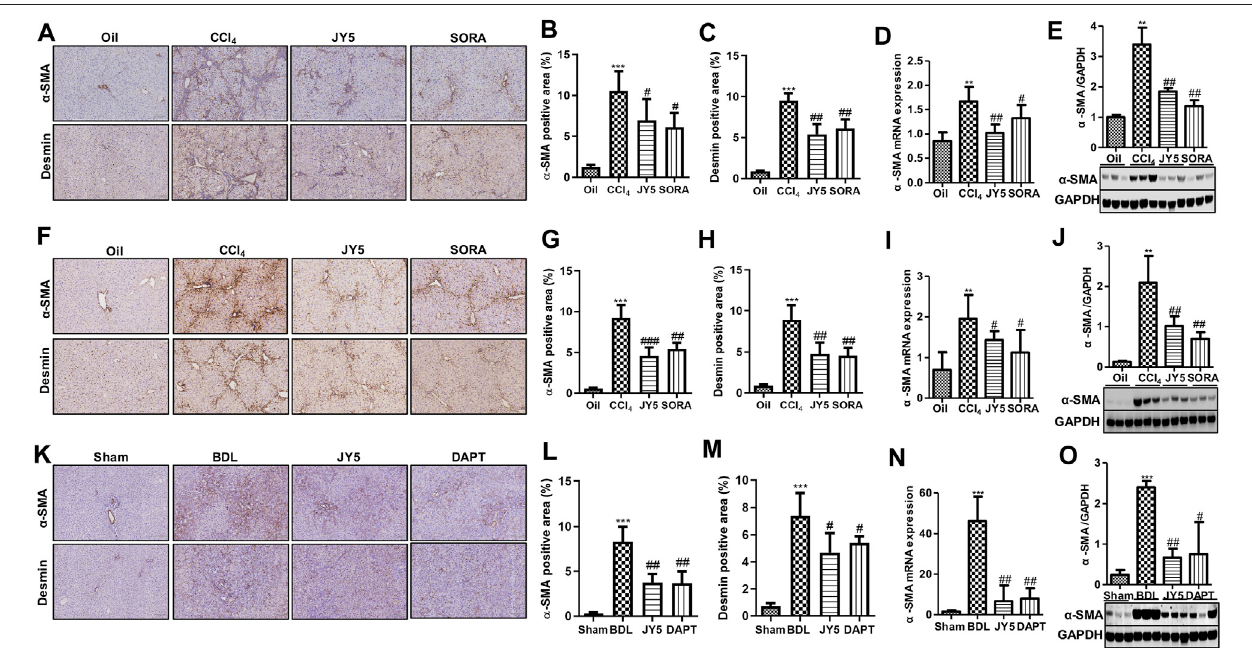
FIGURE 5 | JY5 inhibits the activation of HSCs in vivo . (A) In the CCl 4 -induced rat liver fi brosis experiment, representative images of IHC (100 × ) staining for a -SMA and desmin. Quantitative analysis of immunohistochemical staining for a -SMA (B) and desmin. (C) The protein and mRNA levels of a -SMA were, respectively, analyzed by qPCR (D) and Western blotting (E) . (F) In the CCl 4 -induced liver fi brosis mice experiment, representative images of IHC (100 × ) staining for a -SMA and desmin in liver tissue from mice treated with the various treatments. Quantitative analysis of immunohistochemical staining for a -SMA (G) and desmin. (H) The protein and mRNA levels of a -SMA in mice liver tissue were, respectively, analyzed by qPCR (I) and Western blotting (J) . (K) In the BDL-induced rat liver fi brosis experiment, representative images of IHC (100 × ) staining for a -SMA and desmin in liver tissue. Quantitative analysis of immunohistochemical staining for a -SMA (L) and desmin (M) . The protein and mRNA expression of a -SMA was, respectively, analyzed by qPCR (N) and Western blotting (O) . ** p < 0.01, *** p < 0.001 vs the control group or sham group, # p < 0.05, ## p < 0.01 vs the CCl 4 group or BDL group. Oil: control